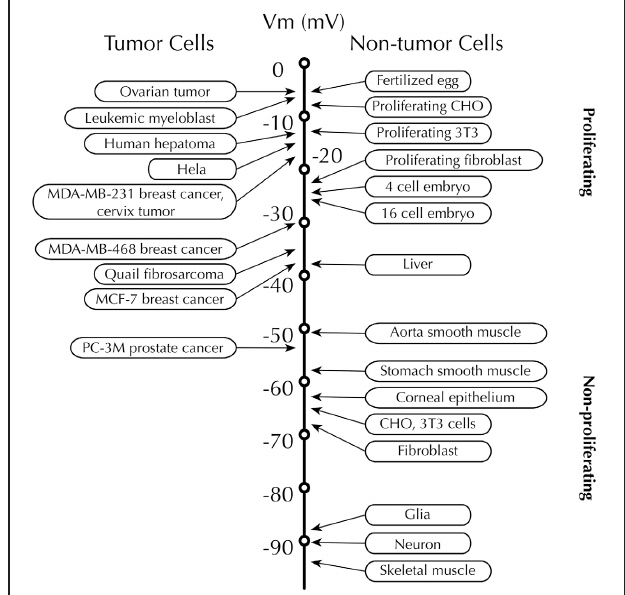
FIGURE 1 | Membrane potential ( V m ) scale. Rapidly proliferating cancer cells possess depolarized V m , while the V m of quiescent cells is generally more negative. Proliferative somatic cells are also depolarized, suggesting that V m is functionally instructive in cell development (Levin, 2007b). Scale adapted from Binggeli and Weinstein (1986), with additional data from Fraser et al. (2005); Mycielska et al. (2005); Yang et al. (2012).